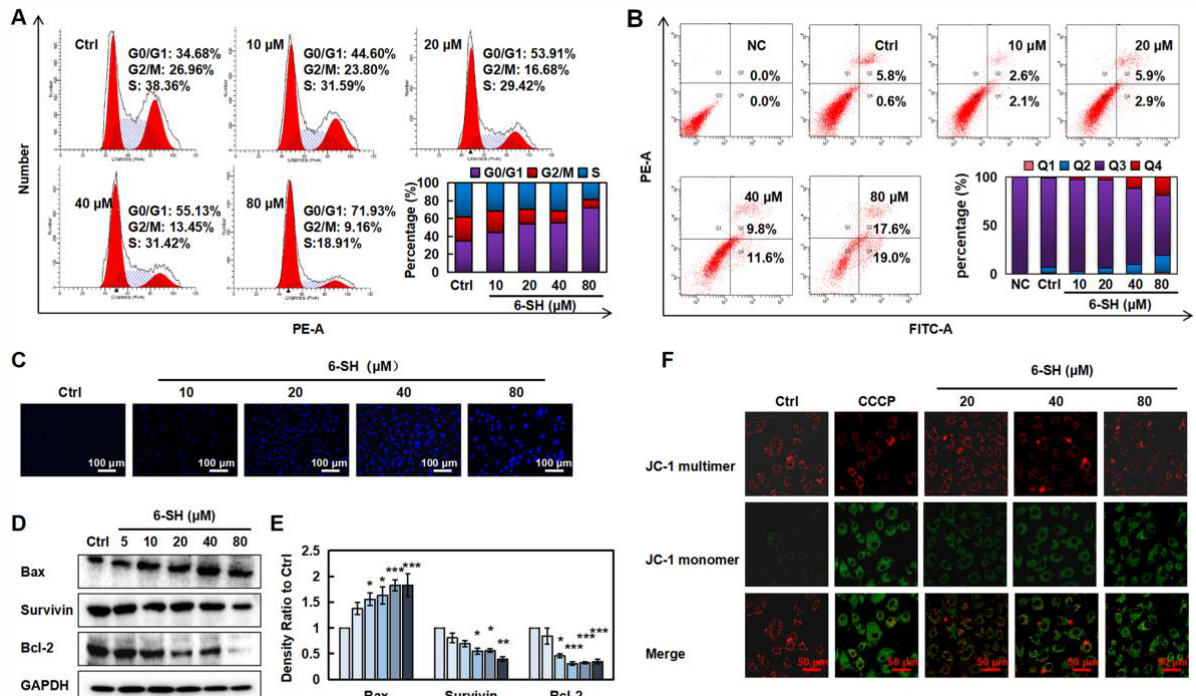
Figure 2. 6-SH arrested the cell cycle and induced apoptosis. ( A ) Cells were cultured with 0 – 80 µM 6-SH for 24 h, then, the DNA content was texted. Histograms show the percentage of cells in different phase. ( B ) Cells were treated with 0 – 80 µM 6-SH for 24 h. 6-SH-induced apoptosis was detected. “Q2” and “Q4” represent late and early apoptosis in histograms, respectively. ( C ) Cells were treated with 0 – 80 µM 6-SH for 24 h, and the changes of nuclear chromatins were detected. ( D , E ) Cells were treated with 0 – 80 µM 6-SH for 24 h, and the indicated proteins were assayed. Histograms show the density ratio ( n = 3). ( F ) Cells were treated with 0-80 µM 6-SH for 24 h, and the MMP was analyzed using JC-1 probe. Values represent the means ± SD. * p < 0.05, ** p < 0.01, *** p < 0.001 versus “Ctrl” group.